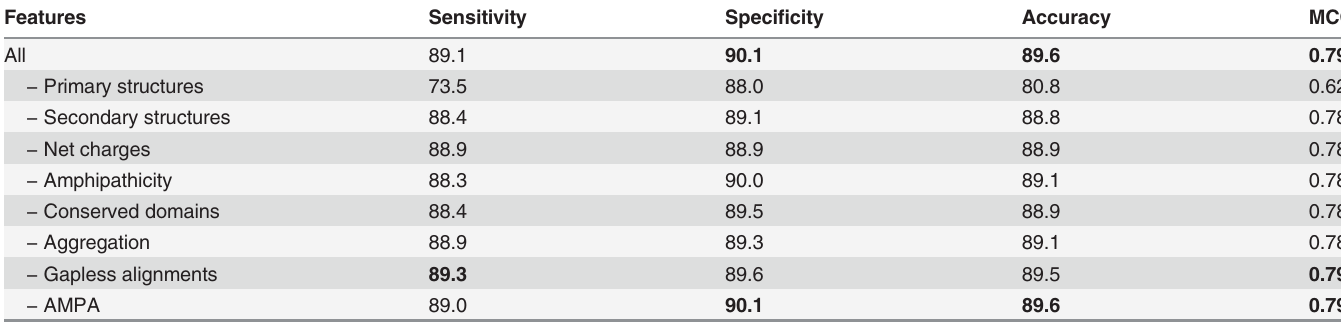
Table 1. Feature ablation study of AMPcore on the comprehensive dataset using 10-fold cross-validation.